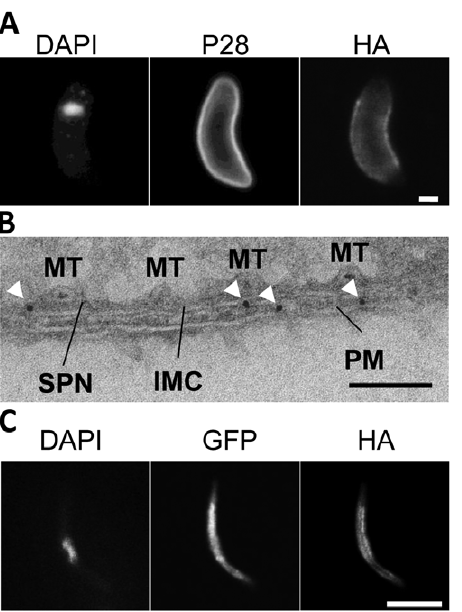
Figure 1. Localisation of IMC1h in ookinetes and sporozoites. A. Single optical section of a mature IMC1h-HA ookinete immuno- stained for HA, P28 and the nucleus stained with Hoechst. The HA tagged IMC1h localizes to the peripheral edge of the ookinete. Both the anterior and posterior ends are spared by IMC1h-HA whereas P28 covers the whole surface of the ookinete. Scale bar=1 m m. B. Representative TEM section of an IMC1h-HA ookinete immunogold- labelled for HA showing the pellicle. Gold particles (white arrowheads) localise at the IMC. IMC=inner membrane complex, MT=microtubules, SPN = subpellicular network, PM = plasma membrane. Scale bar=100 nm. C. Salivary gland IMC1h-HA sporozoite immunostained for HA and GFP. The nucleus is stained with Hoechst. Single optical section is shown revealing the localisation of IMC1h-HA to the cell periphery. The IMC1h-HA is distributed over the full length of the sporozoite. Scale bar=5 m m.